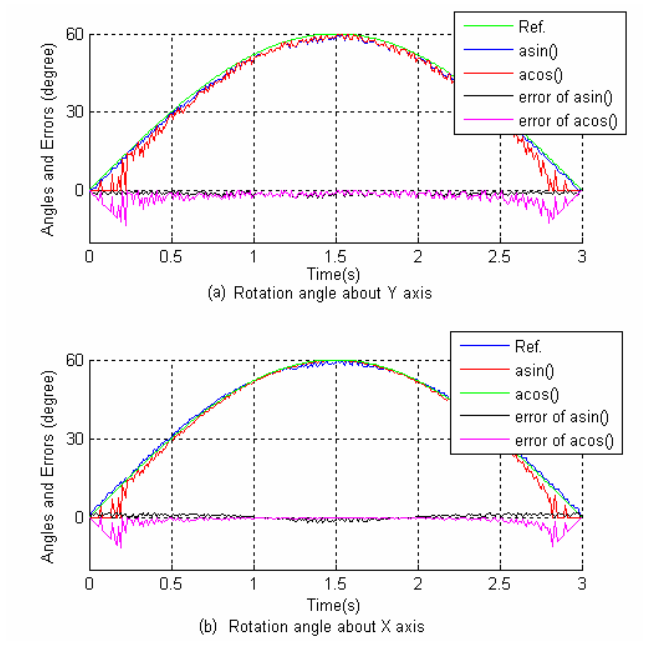
Fig.6 Calculated rotation angles θ y , θ x with noises in half a motion circle (0-60°). Ref means given signal, asin means calculated by arcsine, acos means calculated by arccosine, error by acos means the error when angles are calculated by arccosine, error by asin means the error when angles are calculated by arcsine